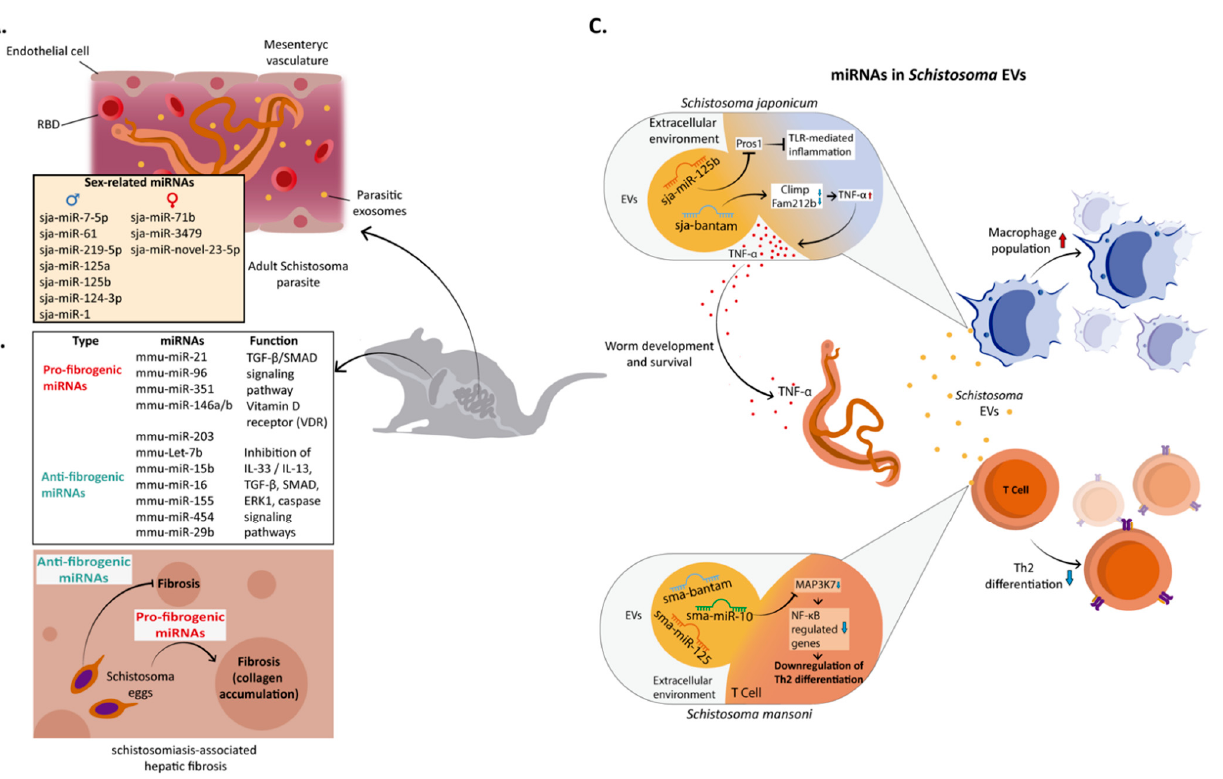
Figure 1. MicroRNAs during Schistosoma infection. ( A ) MiRNA expression in Schistosoma. In the parasite, the expression of miRNAs varies at different developmental stages; some are gender- biased. Parasite miRNAs are involved in the regulation of sexual differentiation, maturation, mating, and reproduction; ( B ) Role of miRNAs in liver injury and hepatic fibrosis. Several miRNAs are dysregulated and documented as pro-fibrogenic (favoring fibrosis; red) or anti-fibrogenic (inhibiting fibrosis; green). Schistosoma eggs produce both responses in liver tissue. Adult Schistosoma parasites accumulate in mesenteric vasculature and release miRNAs-EVs with immunomodulatory effects; ( C ) Effects of Schistosoma miRNAs released in EVs on target cells. Schistosoma releases miRNAs-EVs to regulate the host’s immune response. These miRNAs-EVs are composed of sma-miR-10, sma-miR-125, and sma-bantam in S. mansoni , while miR-125b and bantam are found in S. japonicum EVs. During S. mansoni infection, EVs fuse with T lymphocytes. The release of miR-10 into the T cell cytoplasm modulates the signaling pathway through MAP3K7 and regulates genes negatively depending on NF-k β activation, diminishing T cell differentiation into Th2 subpopulations. Alternatively, during infection of mice by S. japonicum , EVs fuse with macrophages, and miRNA content inhibits the TLR-mediated inflammation (Sj-miR-125b) or stimulates the production and release of TNF- α to the extracellular environment, a molecule related to parasite development and survival. This process also promotes the increase in the macrophage population and may influence gene expression in Schistosoma . Adobe Illustrator was used to elaborate the